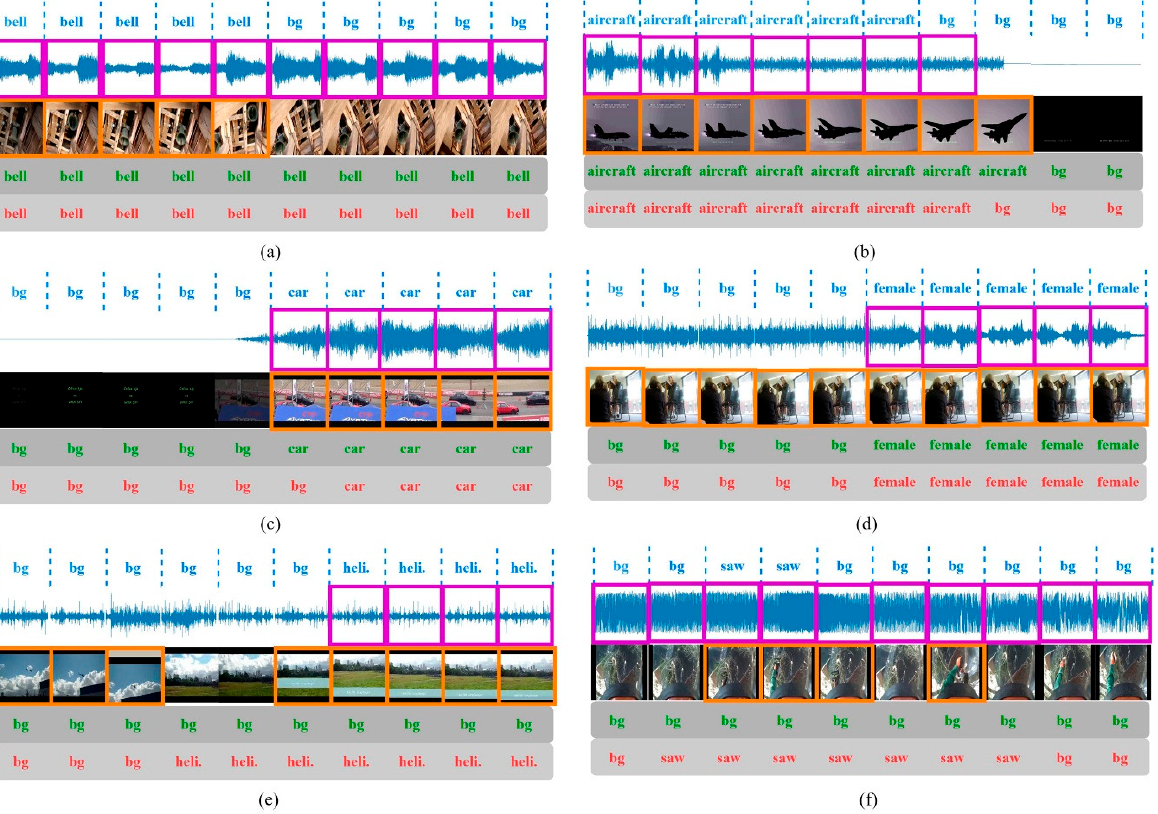
Figure 8. Qualitative results of our methods on the AVE dataset are shown in ( a – f ). For each sample, the annotations of the data are given in the first row. The purple box on the audio wave diagram indicates that the sound emitted by the target is audible, while the orange box on the frame represents the sounding object (person) that is visible at this moment. Predictions directly made by features from AV‑BT are shown in the fourth row, and the results of TACMA are shown in the last row. ‘bg’ denotes background, and ‘heli.’ in ( e ) represents helicopter. Best viewed in color.